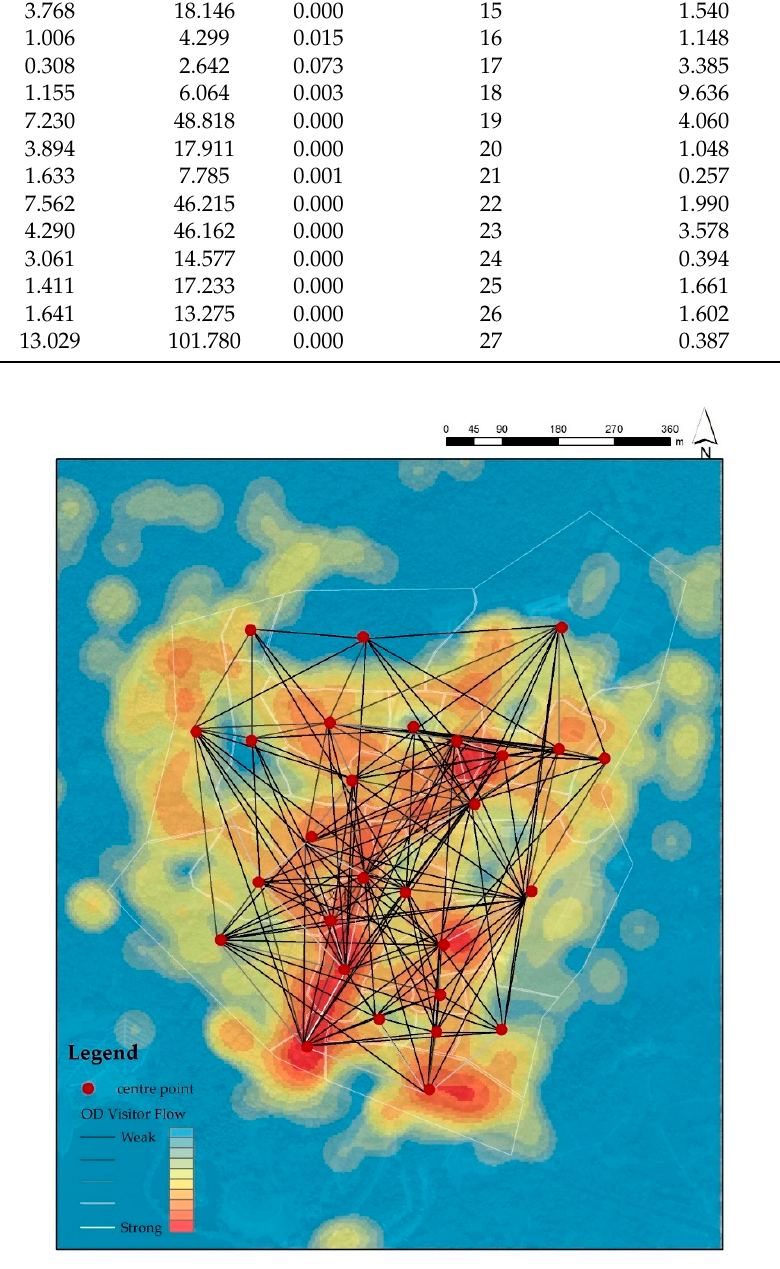
Figure 3. Tourists OD figure.